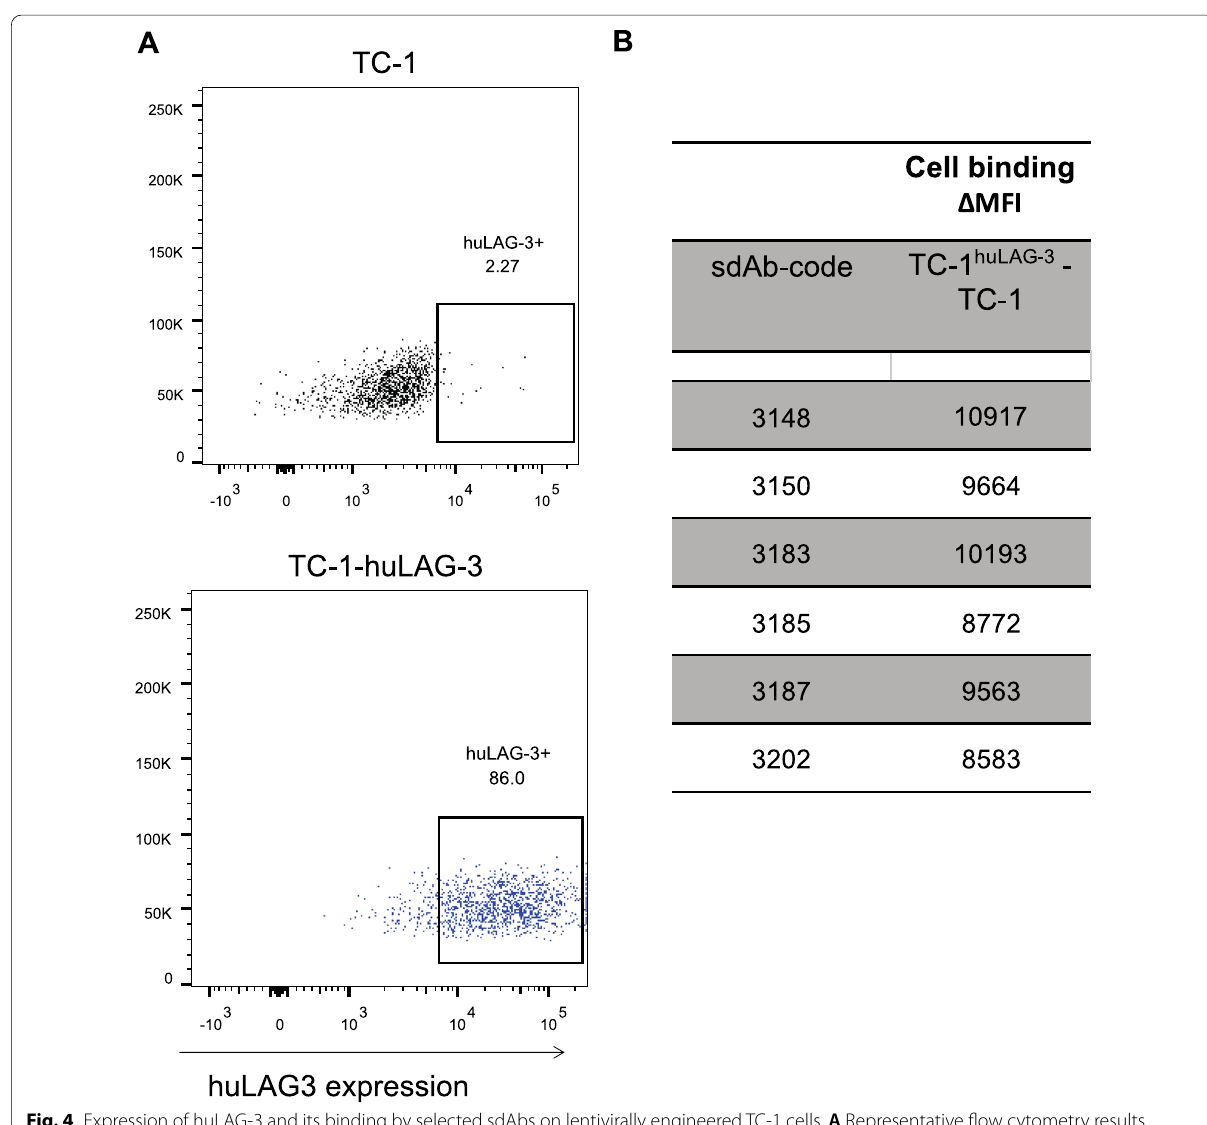
Fig. 4 Expression of huLAG-3 and its binding by selected sdAbs on lentivirally engineered TC-1 cells. A Representative flow cytometry results, showing staining of TC-1 cells (black line) or TC-1-huLAG-3 cells (blue line) with an antibody specific for huLAG-3. B The MFI of TC-1 cells was used to determine the fold increase in MFI when these sdAbs bound to TC-1-huLAG-3 cells ( n =